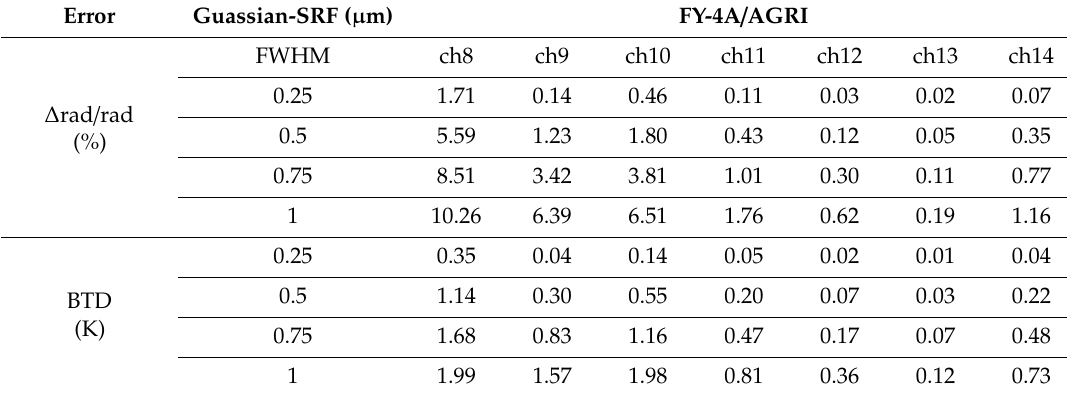
Table 1. Spectral convolution di ff erences (SCDs) calculated by simulated SRFs for seven IR bands of FY-4A / AGRI with six standard atmospheric profiles, in which the radiance di ff erence is calculated as the percentage (unit: %) of radiance di ff erence to the total radiance as well as BTD (unit: K) using convolution results in wavenumber space as